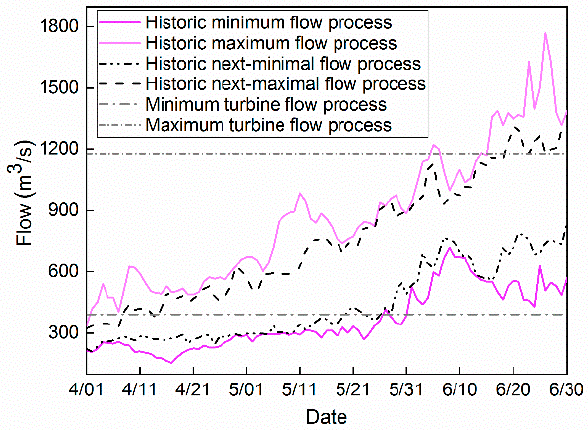
Figure 3. Schematic diagram of the ecological flow constraint.